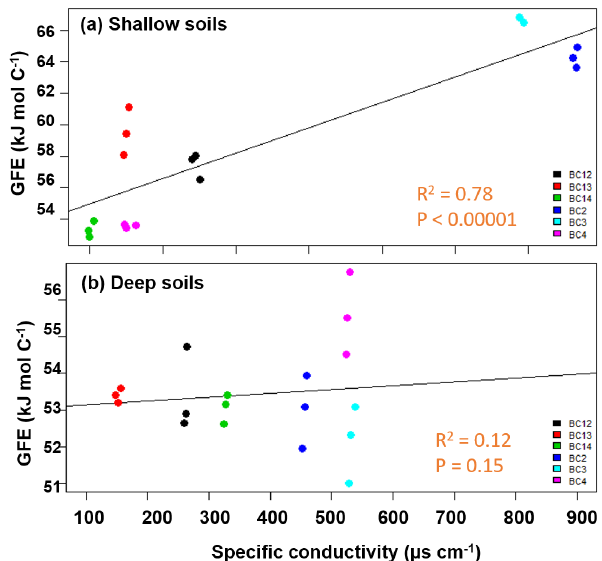
Figure 3. Average Gibbs free energy (GFE) of samples in the water fraction of shallow soils impacted by tidal inundation increased with increasing specific conductivity (a) , while no change was observed in the deeper soils (b) . The salinity of the soil samples did not follow a clear spatial